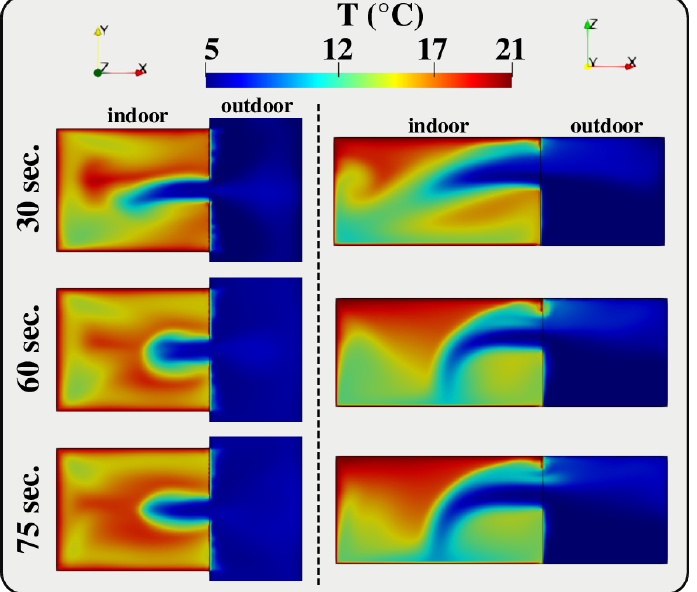
Figure 3. Indoor-outdoor temperature field. Case: Natural ventilation due to a negligible wind speed outdoors U = 0 and a lower outdoor temperature, walls-particles-interaction: unstick . Left hand side Column: XY-plane perspective view; Right hand side Column: XZ-plane perspec- tive